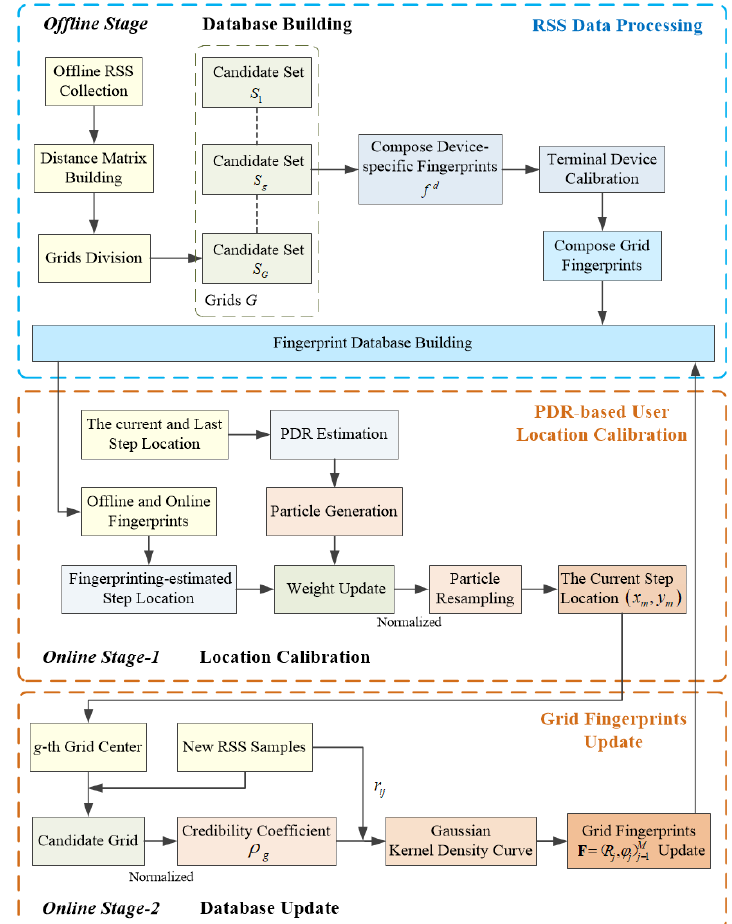
Figure 1. System architecture of the proposed RMPAEC.